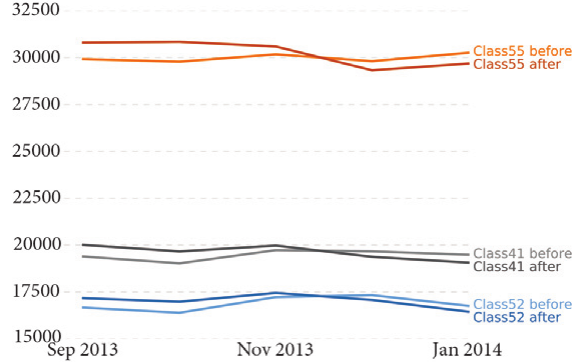
Fig. 4. Mean GVW in kg of Class 55, 52 and 41 vehicles before and after adjusting for temperatures influence – A3 data Table 1. Coefficient of variation of mean GVW before and after